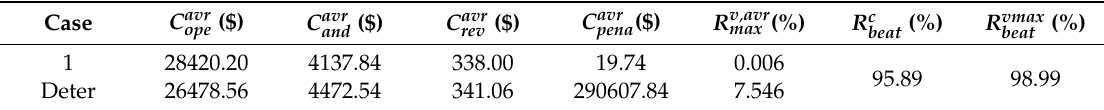
Table 6. Statistical feasibility check